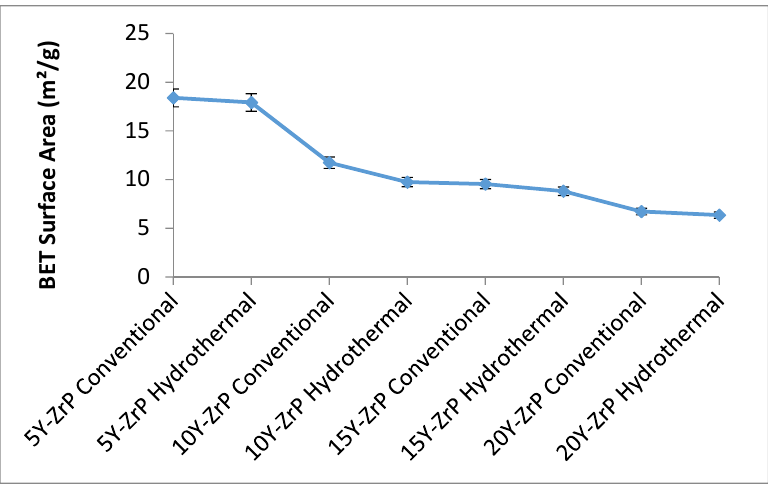
Figure 5. BET surface area of the synthesised Y–ZrP samples.